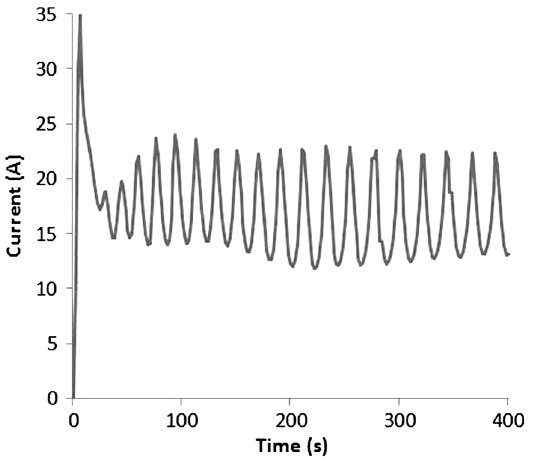
FIG. 16. Current oscillations observed during VEP of single- cell cavity at 20 V.